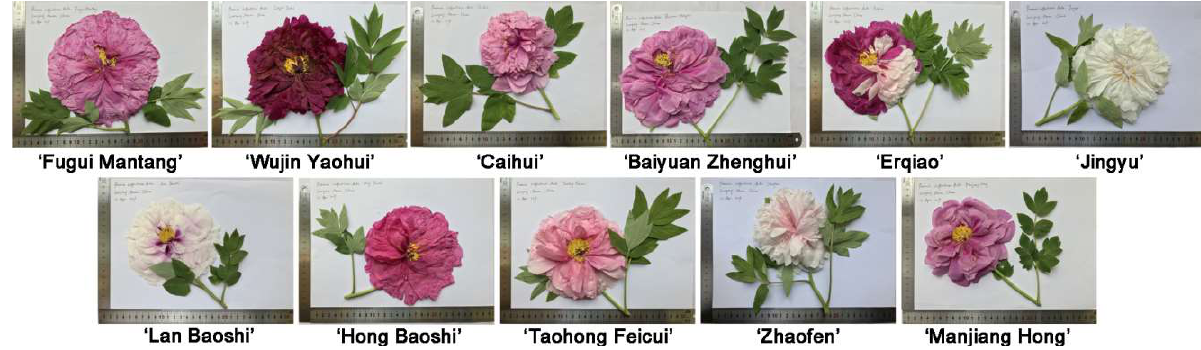
Figure 1. Photographs of flowers of the eleven woody peony cultivars ( Paeonia × suffruticosa Andr.). Hydro-distillation of the fresh flowers afforded essential oil yields of 0.11–0.25% ( w / w , on dry basis) from the eleven cultivars (Table 1). Results of analysis of variance (ANOVA) showed that the essential oil yield was influenced by the factor of woody peony cultivar ( p < 0.05). The post-hoc test which utilized Tukey’s method for